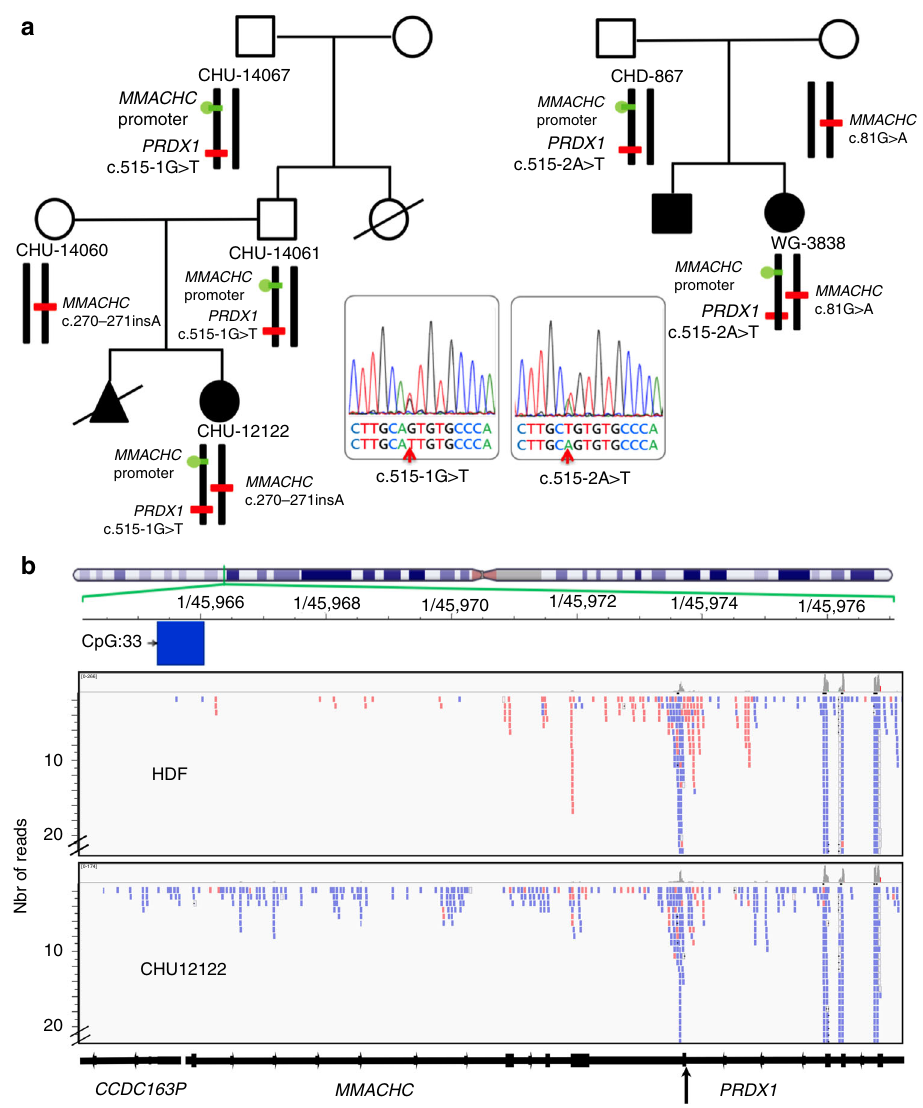
Fig. 5 Pedigrees derived from whole-genome sequencing and epigenome analyses and RNA-Seq in case fi broblasts. a Pedigrees derived from WGS of DNA by HiSeq X Ten Illumina System in cases CHU-12122 and WG-3838 and their relatives. WGS evidences c.515-1G > T and c.515-2A > T mutations of PRDX1 , in cases CHU-12122 and WG-3838 and the relatives who bear the secondary epimutation, respectively. The mutations are absent in relatives, who bear the MMACHC heterozygous mutation. b NGS sequencing of RNA from case CHU-12122 and HDF control fi broblast line. Overlapping antisense (in blue) transcription of PRDX1 / MMACHC / CCDC163P trio of genes is predominant in CHU-12122 fi broblasts while MMACHC sense transcription (in red) is predominant in HDF control fi